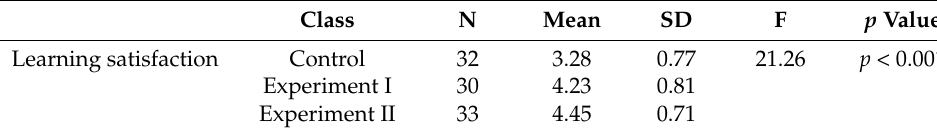
Table 5. Different tests of mathematics learning satisfaction between control class, experiment I, and experiment II using Games-Howel-Based post hoc for multiple